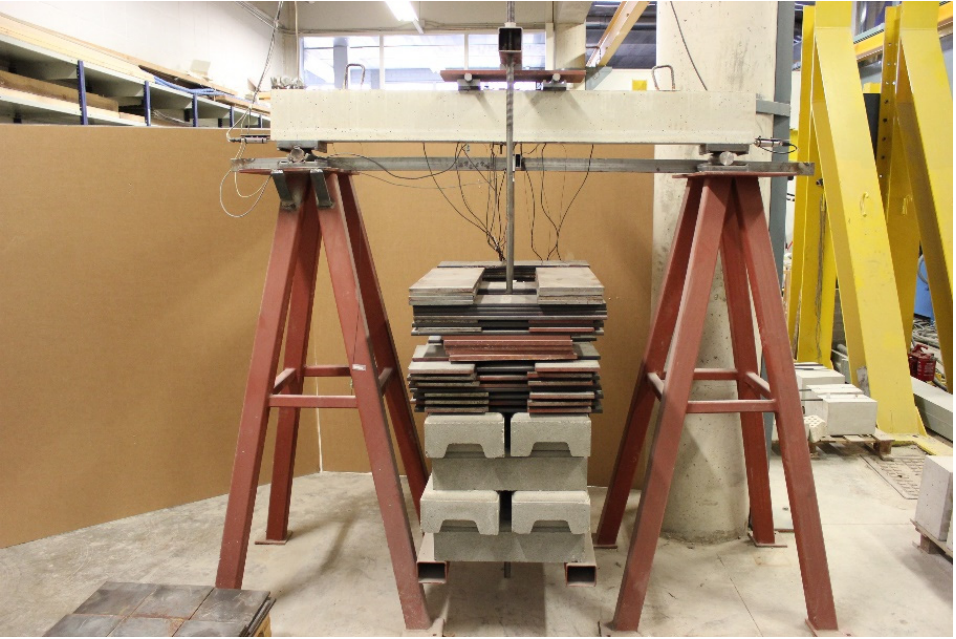
Figure 2. Experimental set-up.